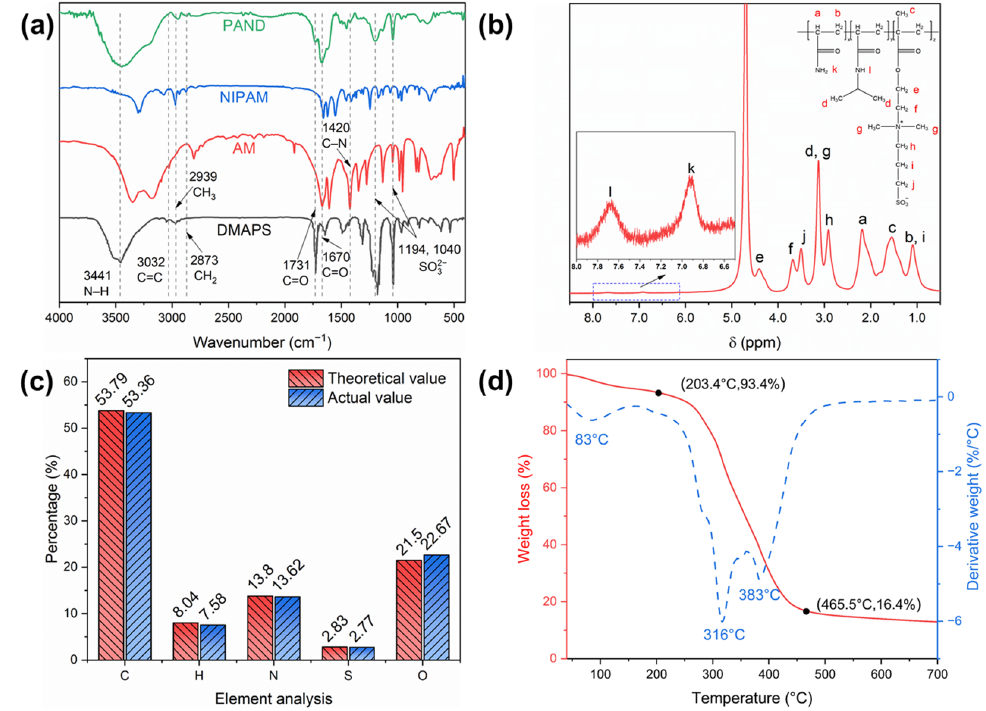
Figure 1. FTIR spectrum ( a ) 1 H NMR spectrum ( b ) elemental analysis ( c ) TGA and DTG curves ( d ) of PAND.